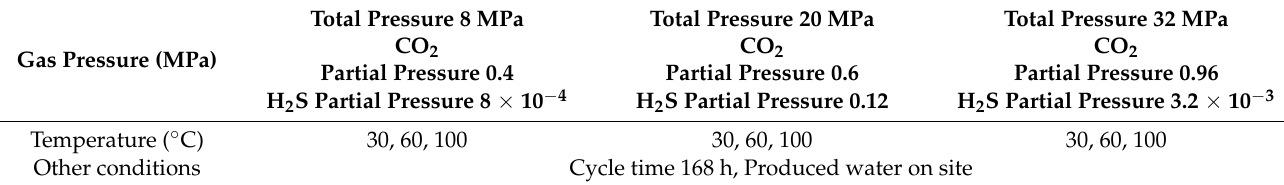
Table 3. High temperature and pressure simulation experimental scheme.